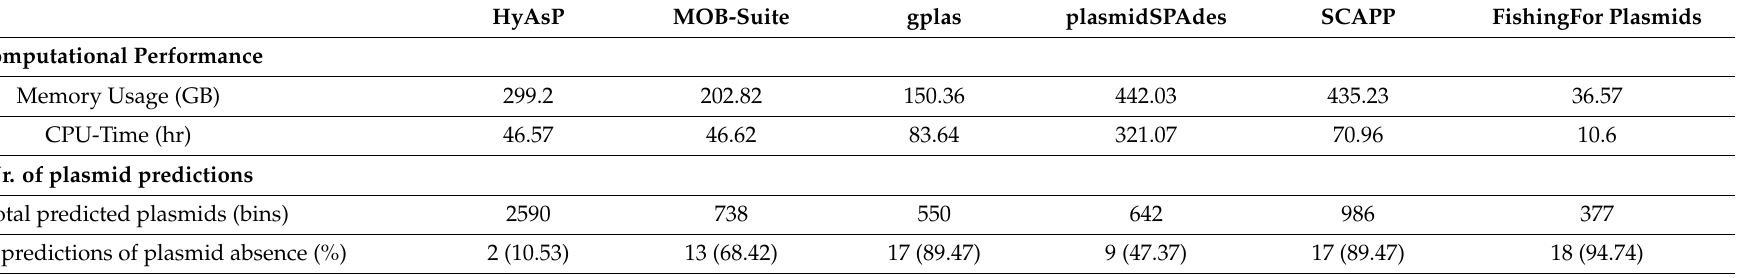
Table 1. Summary of tool’s